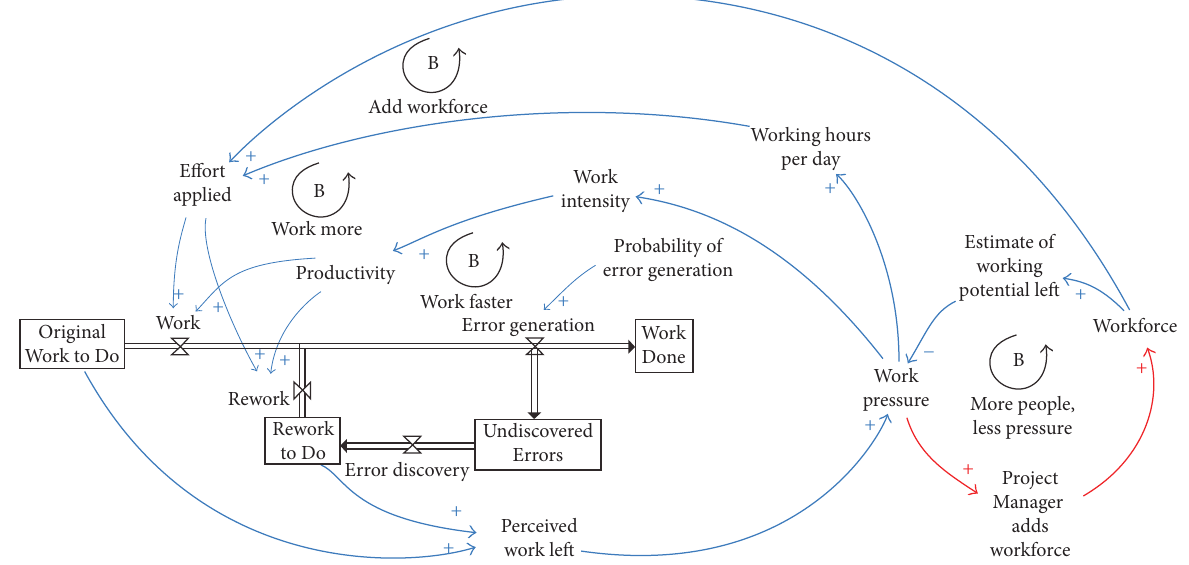
Figure 2: Rework cycle 2/3: the balancing loops.